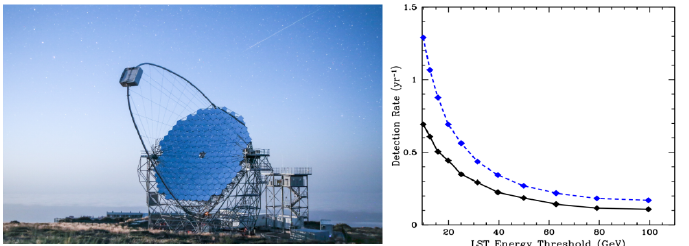
Figure 13. ( Left ) The LST prototype during night operation in La Palma. Picture credit: Tomohiro Inada. ( Right ) GRB detection rate for one of the CTA arrays as a function of the expected LST energy threshold. The curves represent two possible empirical assumptions for GRB spectrum at very high energy; one considering a simple extrapolation of the band emission up to VHE (solid black), the other considering an additional emission component (dashed blue). Reprinted with permission from Ref.